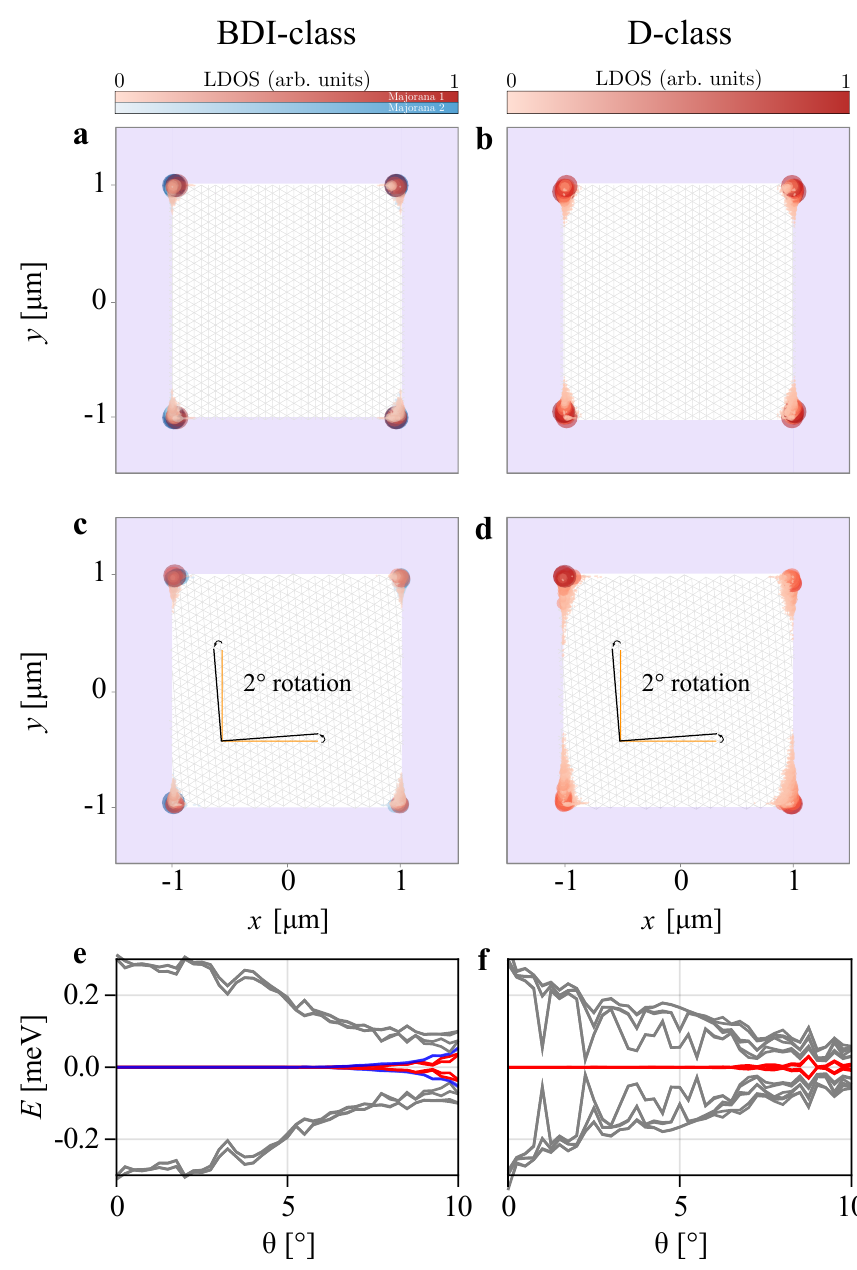
Figure 6: Spatial profile of MBSs, both in pristine (a,b) and imperfect (c,d) samples in configuration B. Left and right columns correspond, respectively, to BDI-class and D-class MBSs [ for parameters marked with dashed lines of Figs. 5(b) and 5(c) ] . In (c,d) contact disorder is 1% and misalignment angle is 2 ◦ . (e,f) Misalignment angle dependence of the low-energy spectrum in otherwise clean samples. In the BDI-class we depict the two Majoranas at each corner in blue and red, while the lone MBSs in the D-class are shown in red. The scaling of the lattice constant in the simulation has only a small effect on the magnitude and evolution of the topological gap in